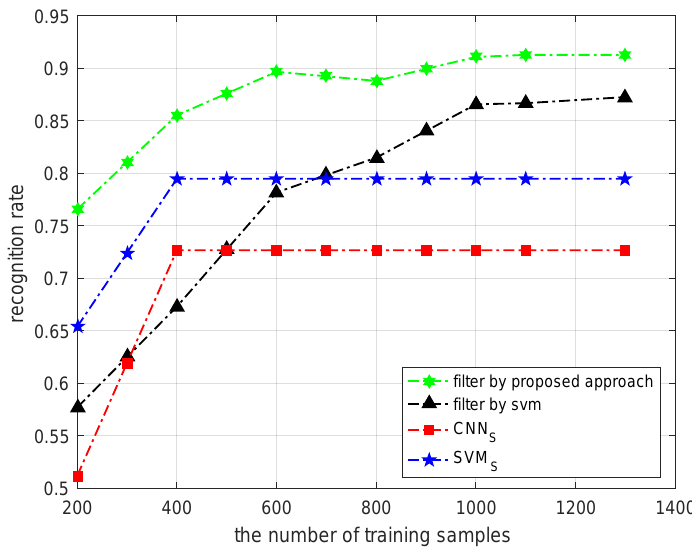
Figure 9. The ATR model recognition performance comparison results obtained by different filtering methods. All recognition models are identical to the architecture of the above ATR